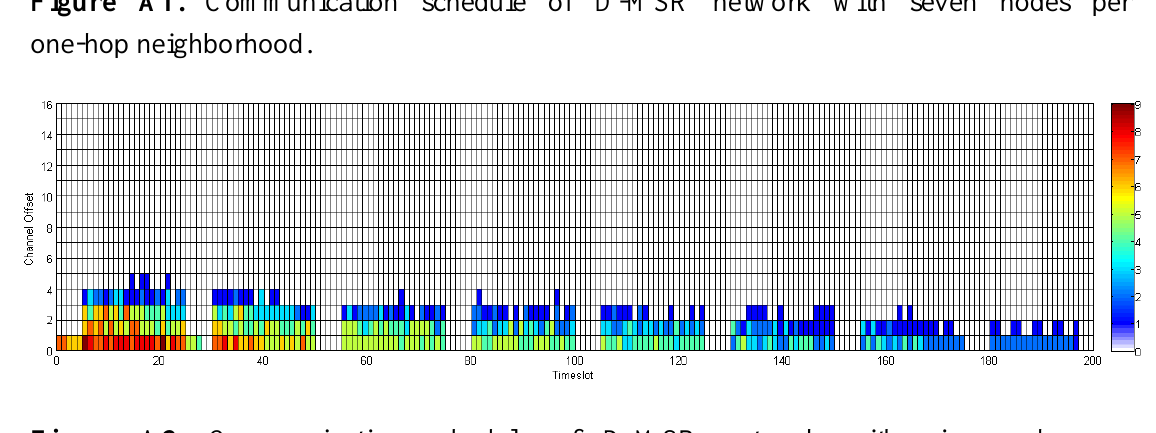
Figure A2. Communication schedule of D-MSR network with nine nodes per one-hop neighborhood.